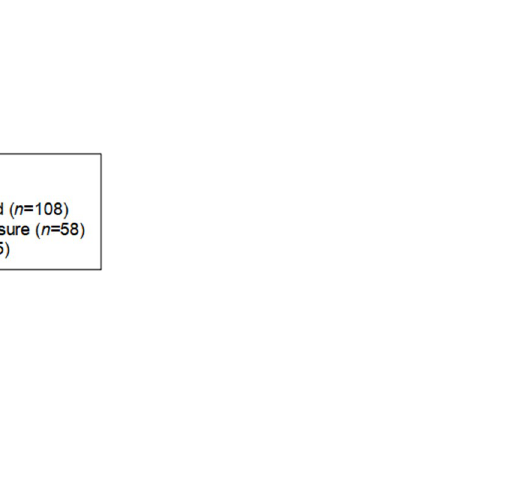
Fig 1. Flow chart of the patient selection process for inclusion in an Outpatient Parenteral Antimicrobial Therapy (OPAT) program at facilities within the Santa Helena\Amil UnitedHealth Group network, October 2016 through June